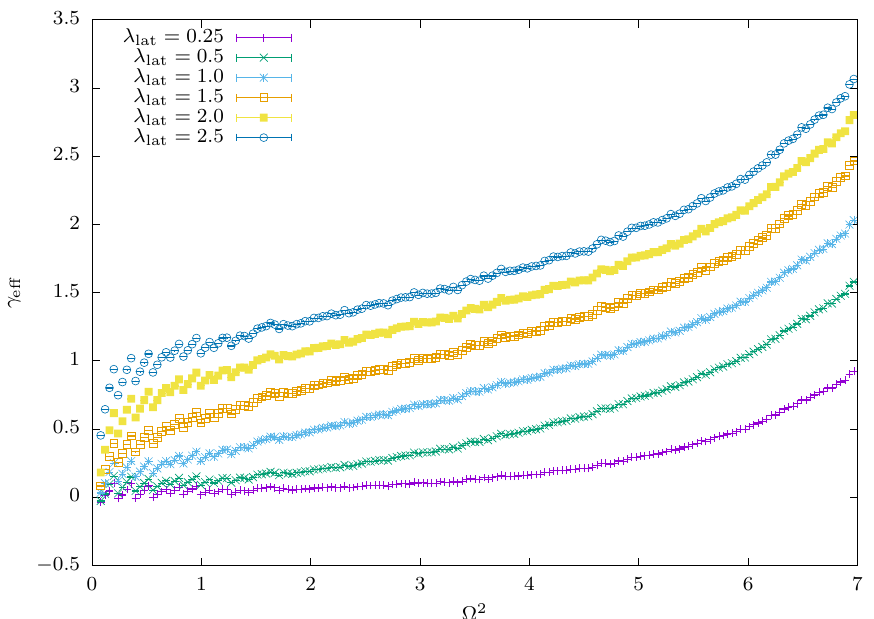
Figure 9. Effective anomalous dimension γ eff obtained from eq. (3.5) with reference scale Ω 2 for all six 16 4 ensembles with gauge group